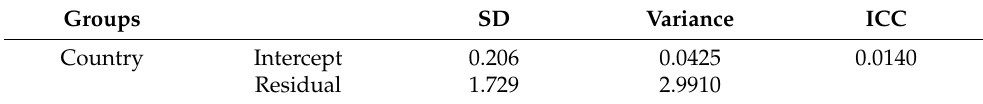
Table 6. Sharing own sexts: estimates of random